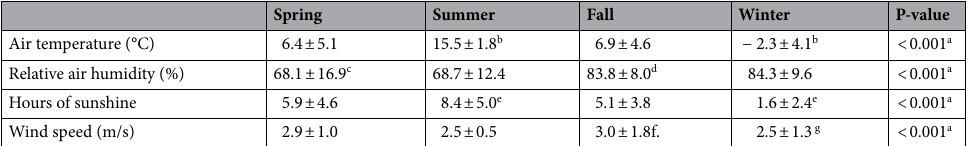
Table 2. Seasonal weather report data from Oslo between 2012 and 2015. a One-way analysis of variance; b P < 0.001 compared to all other seasons (Tukey post hoc test); c P < 0.001 compared to all seasons except Spring (Tukey post hoc test); d P < 0.001 compared to all seasons except Winter (Tukey post hoc test); e P < 0.001 compared to all other seasons (Tukey post hoc test); f P < 0.05 compared to Summer and Winter; g P < 0.01 compared to Spring and Fall (Tukey post hoc